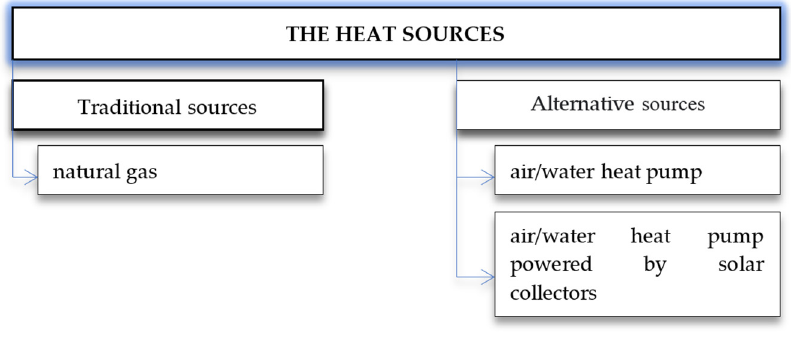
Figure 3. Traditional and alternative heat sources. Source: own elaboration.